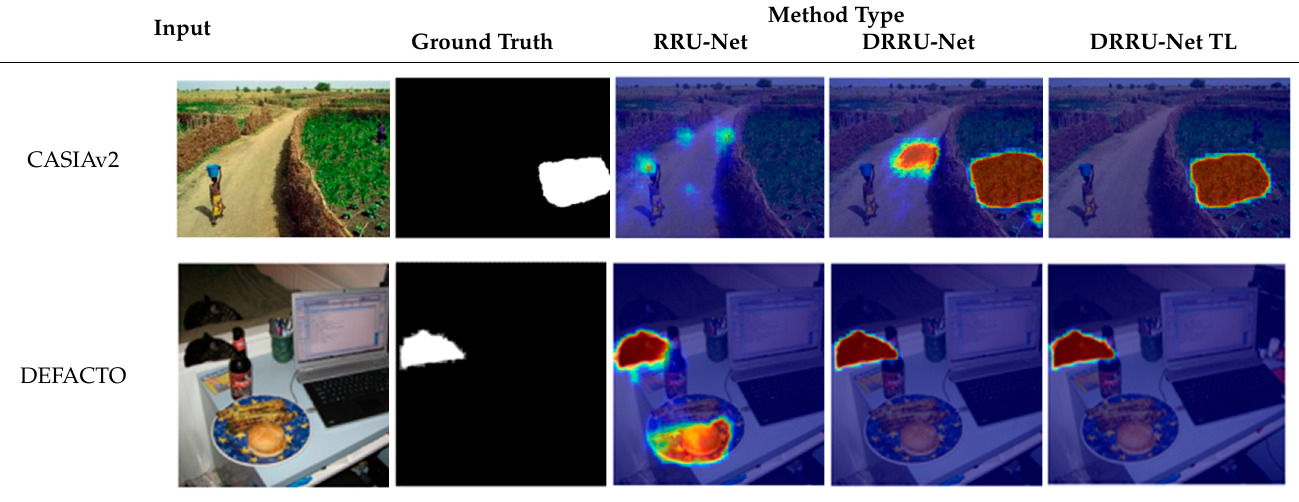
Table 2. Comparison of the segmentation performance of RRU-Net, DRRU-Net, and DRRU-Net TL. Input